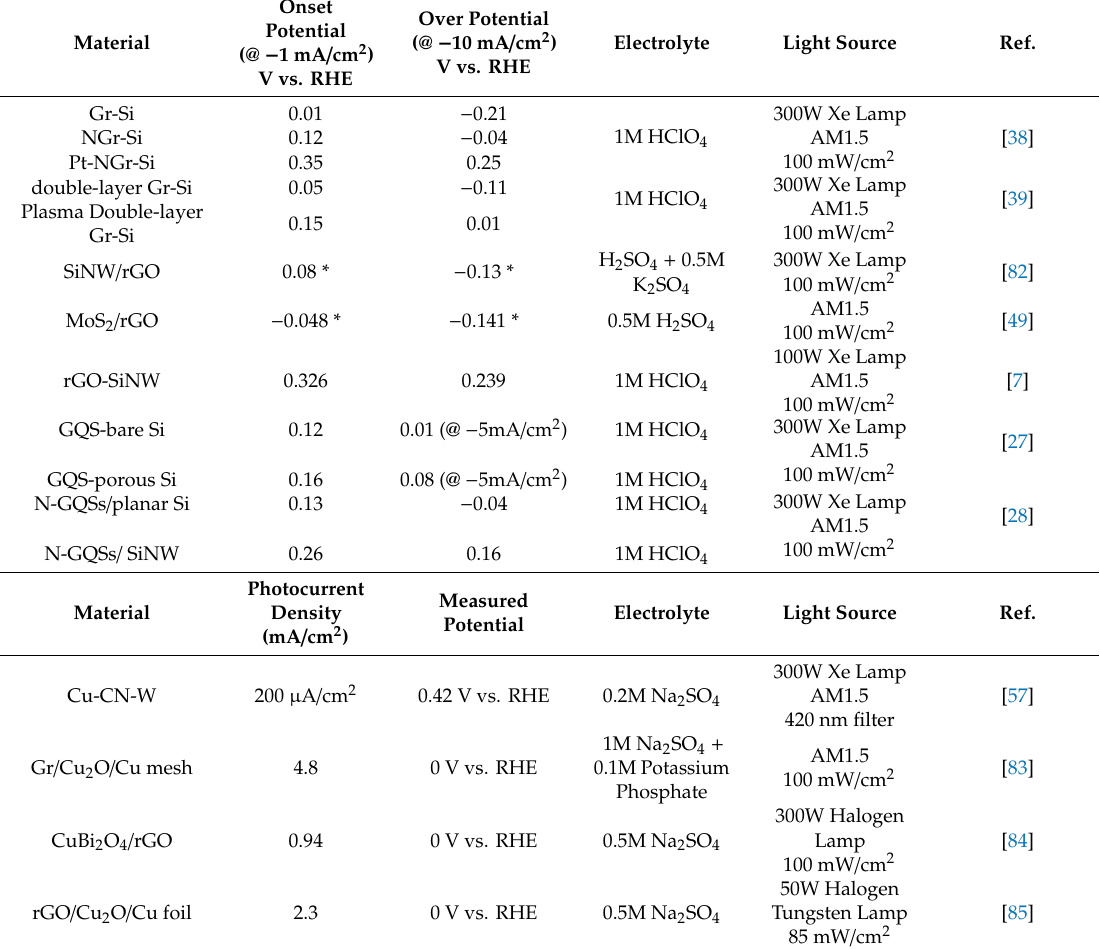
Table 3. Carbon-based materials for photoelectrochemical HER.